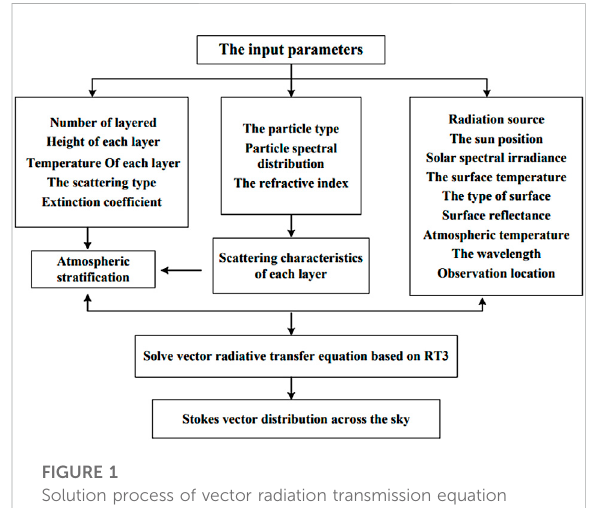
FIGURE 1 Solution process of vector radiation transmission equation based on RT3.